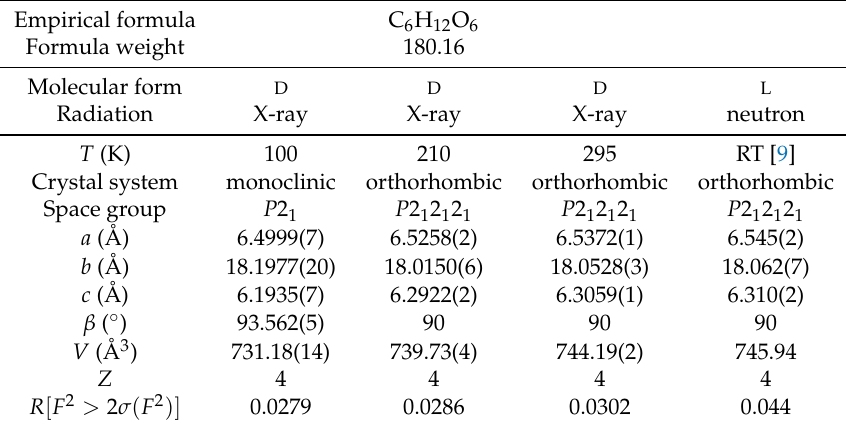
Table 2. Crystal data of sorbose at different